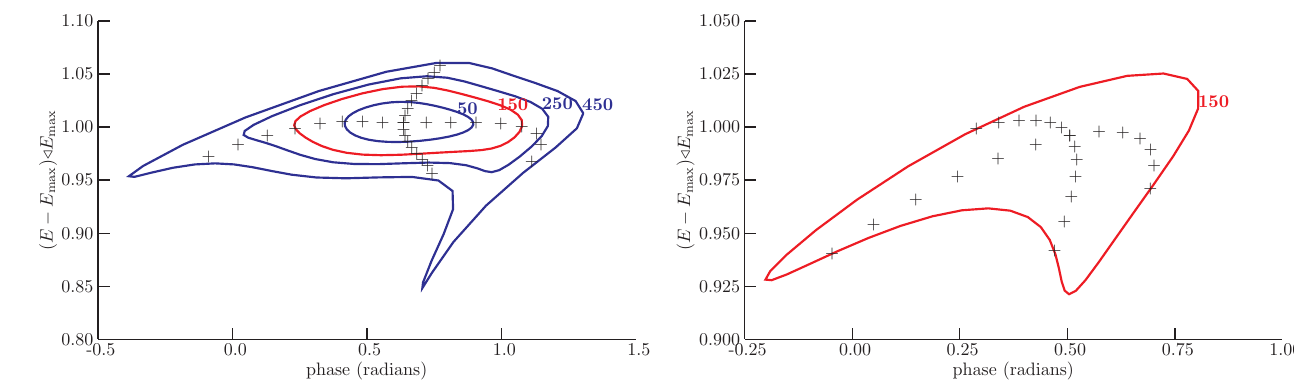
FIG. 36. (Color) Longitudinal tracking starting from an upright ellipse for the 5–10 GeV FFAG. On the left with only 201.25 MHz rf. On the right with third-harmonic rf having voltage equal to 2 = 9 of the fundamental rf voltage. Curves are labeled with their corresponding acceptance. Crosses for both cases started out as horizontal and vertical lines in phase